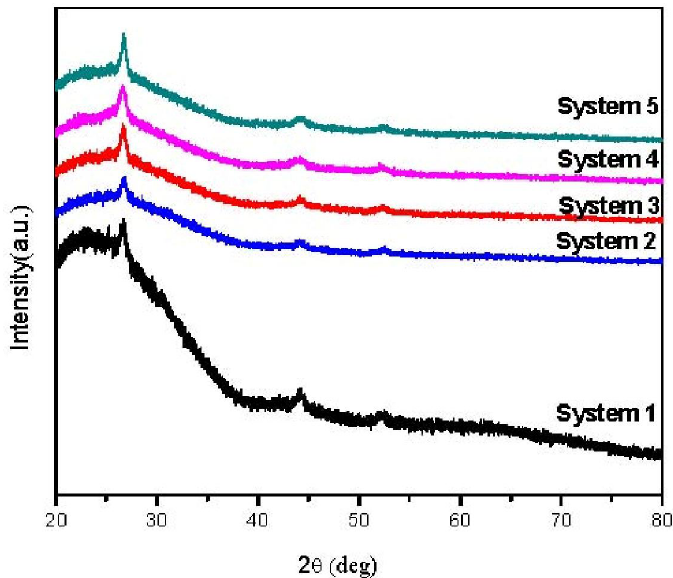
Figure 1. X-ray diffractograms of all systems.